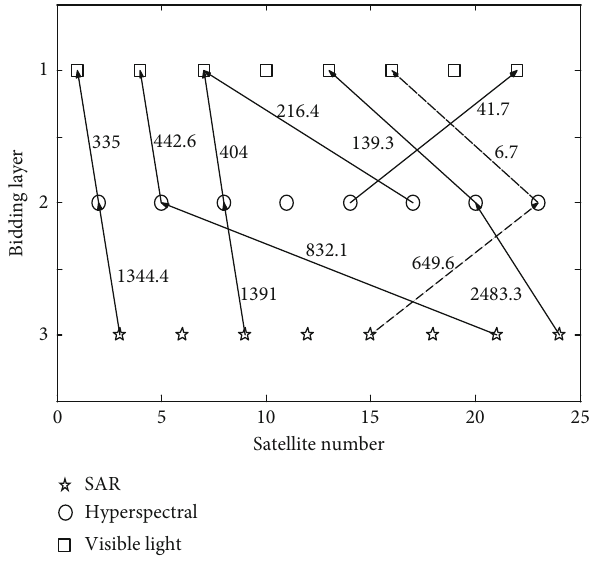
Figure 16: Group bidding model for sensitive target feature con fi rmation